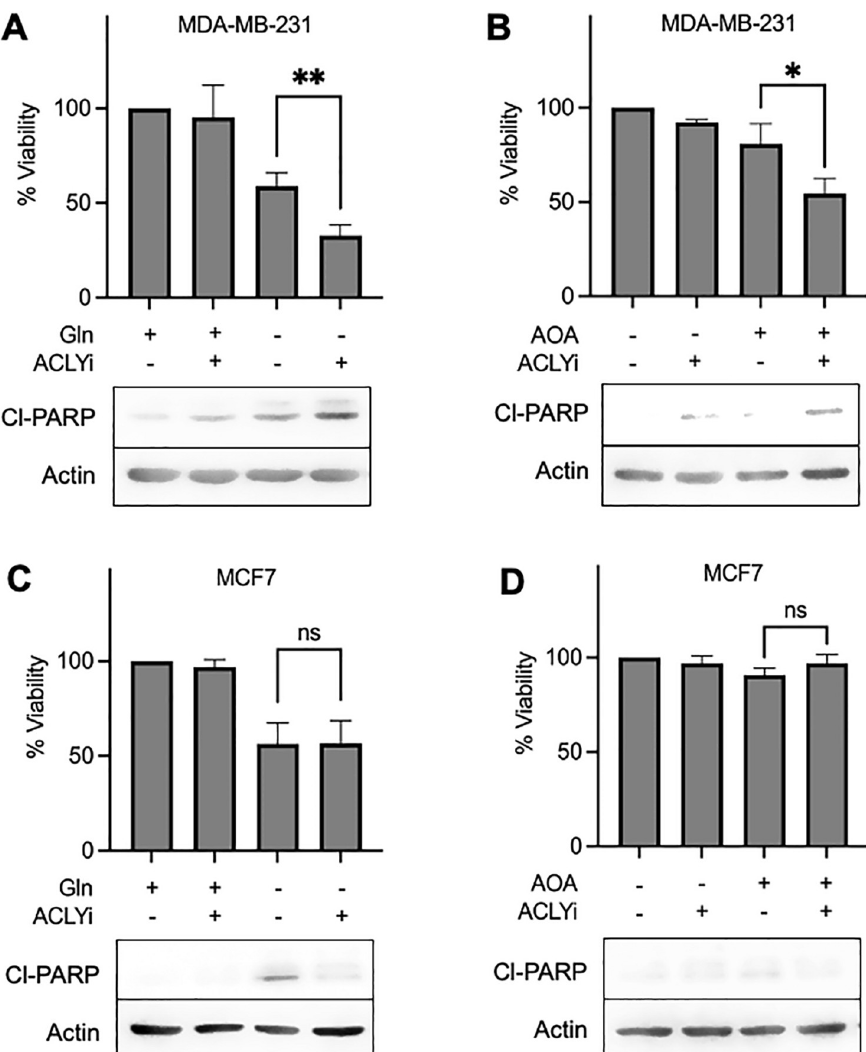
Fig 4. Glutamine deprivation sensitizes KRas-driven cancer cells to ACLY inhibition. ( A ) MDA-MB-231 cells were plated at 60% confluence in 96-well plates in complete medium (CM) containing 10% FBS. After 24 hr, cells were shifted to medium containing or lacking glutamine for 48 hr. ACLY inhibitor (ACLYi) (40 μ M) was added for the last 24 hr. Plates were read in a plate reader and analyzed for cytotoxicity via XTT assay. Through concomitant experiments, lysates were collected and analyzed for protein expression via Western blot. ( B ) MDA-MB-231 cells were plated as in A . After 24 h, cells were shifted to medium containing or lacking AOA (0.5 mM) for 48 hr. ACLYi (40 μ M) was added for the last 24 hr. Plates were read in a plate reader and analyzed for cytotoxicity via XTT assay. Lysates were also collected and analyzed for protein expression via Western blot. ( C ) MCF7 cells were plated and treated as in A . Plates were read in a plate reader and analyzed for cytotoxicity via XTT assay. In concurrent experiments, lysates were collected and analyzed for protein expression via Western blot. ( D ) MCF7 cells were plated and treated as in B . Plates were read and analyzed for cytotoxicity via XTT assay. Lysates were collected and analyzed for protein expression via Western blot. All experiments were repeated two or more times. Error bars represent ± SEM. Unpaired Student’s t-test was performed for statistical analysis. The Western blots shown are representative of experiments repeated at least two times.